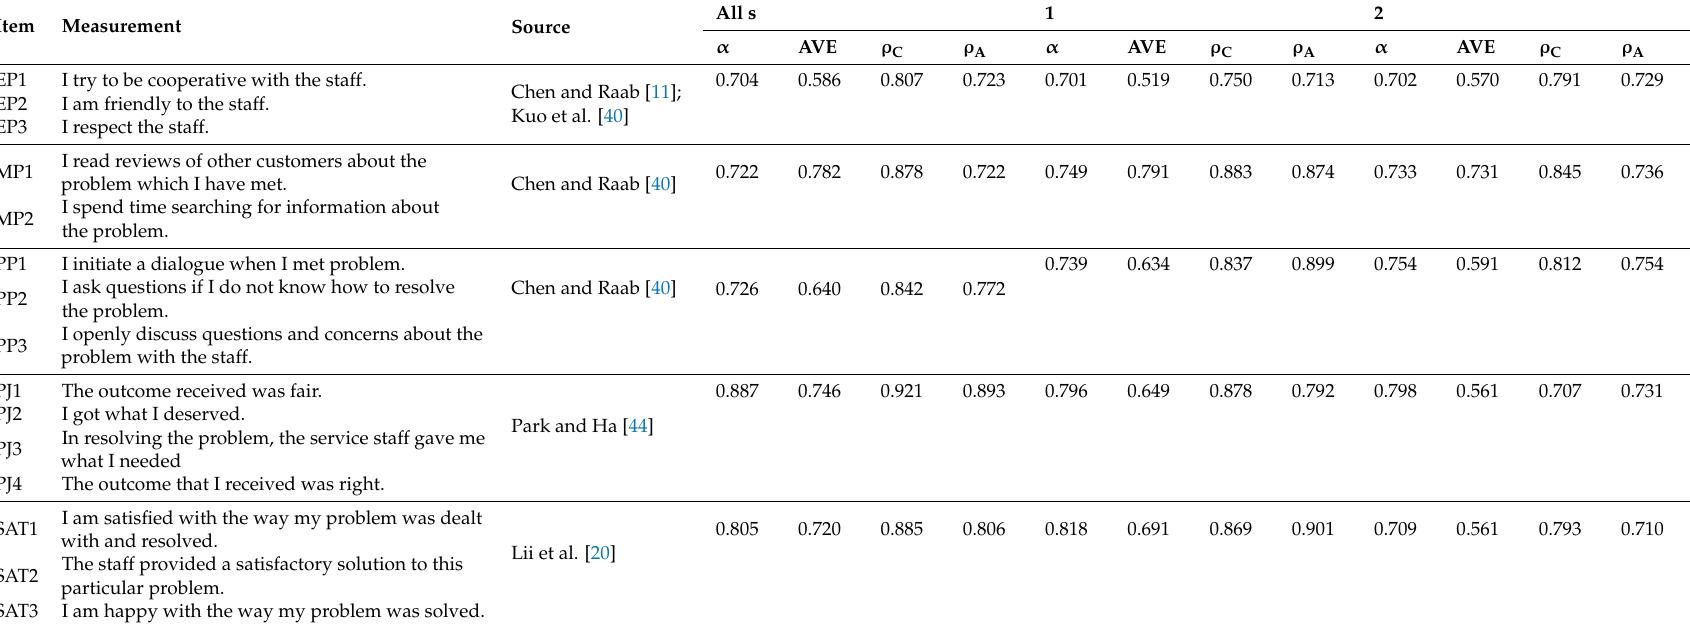
Table 4. Reliability and validity of construct